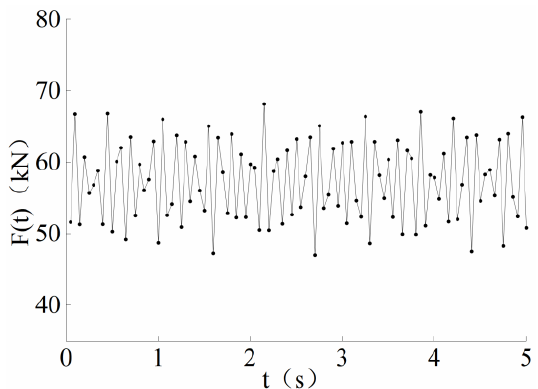
Figure 7. Acceleration time history of vibration load when a train pass.